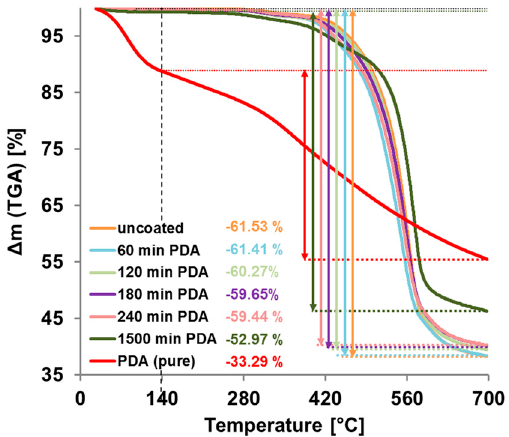
Figure 7. Thermogravimetric Analysis (TGA) measurements of uncoated and polydopamine (PDA)-coated PES membranes and of pure PDA. The mass loss between 140 °C and 700 °C is marked with coloured arrows and the value is given for each sample.